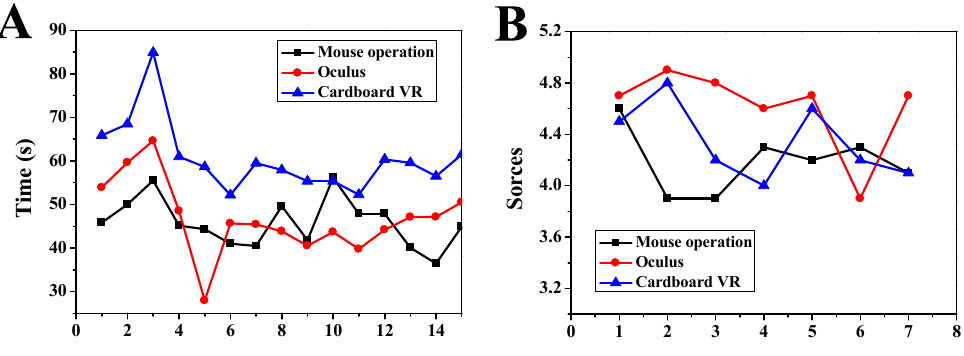
Figure 13. ( A , B ) Performance testing of VR interactive systems. Figure 13. ( A-B ) Performance testing of VR interactive systems. Figure 13. ( A-B ) Performance testing of VR interactive systems.